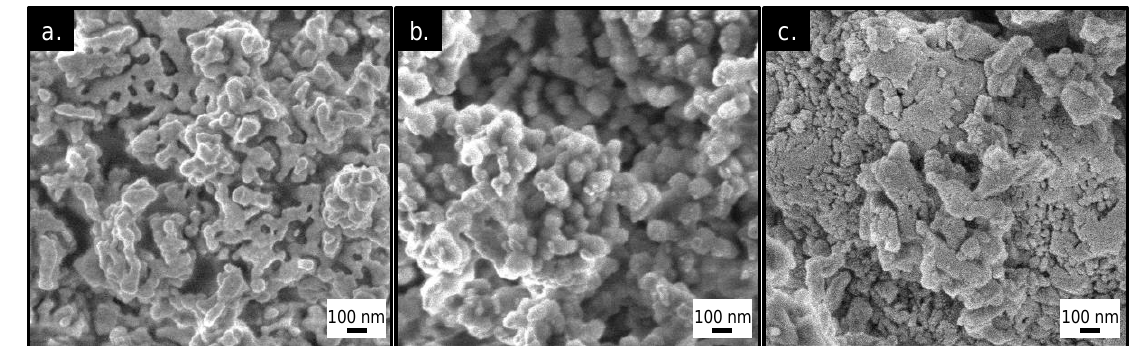
Figure 1. Field emission scanning electron microscope (FESEM) images of uncalcined ( a ) h-HZSM-5, ( b ) c-HZSM-5 and ( c ) HZSM-5.